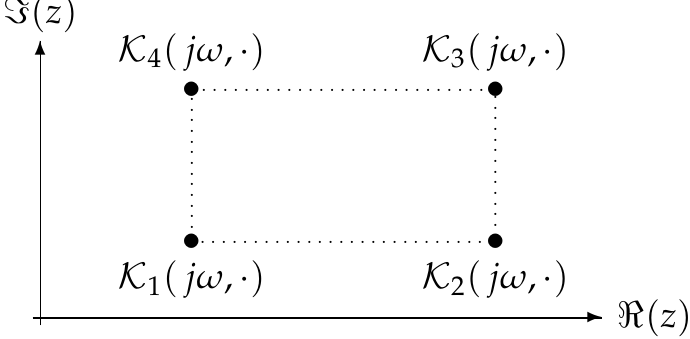
Figure 2. Value set associated with an interval polynomial family.